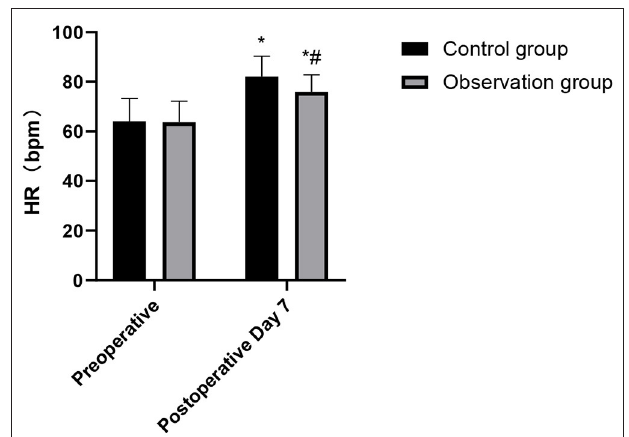
FIGURE 3 | Comparison of HR changes in the patients of the two groups. Compared with preoperative, * p < 0.05. Compared with the control group, # p < 0.05.